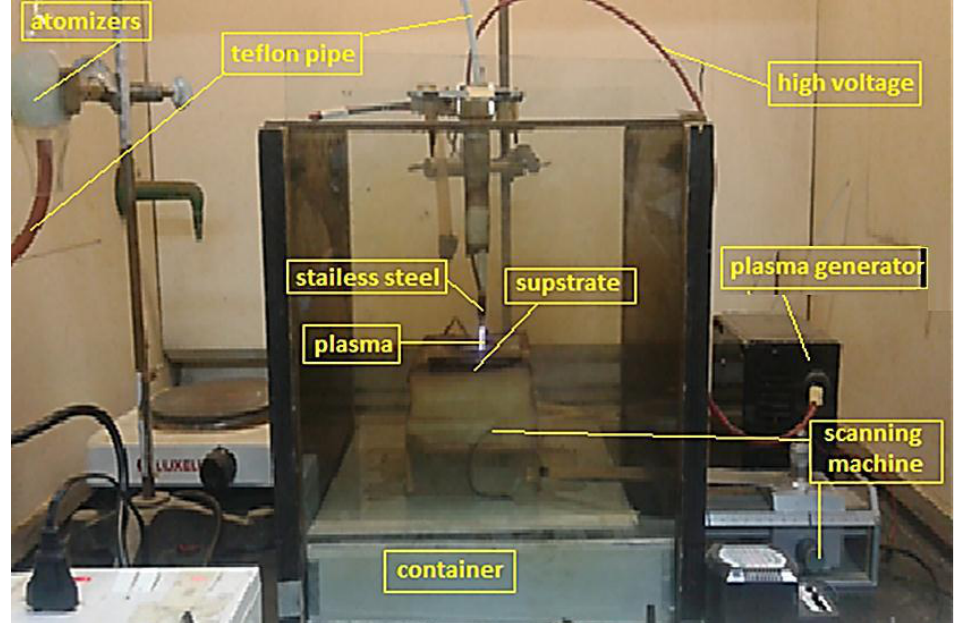
Fig. 1: Schematic diagram for PANI/MWCNTs nanocomposites thin films preparation by non-equilibrium atmospheric pressure plasma